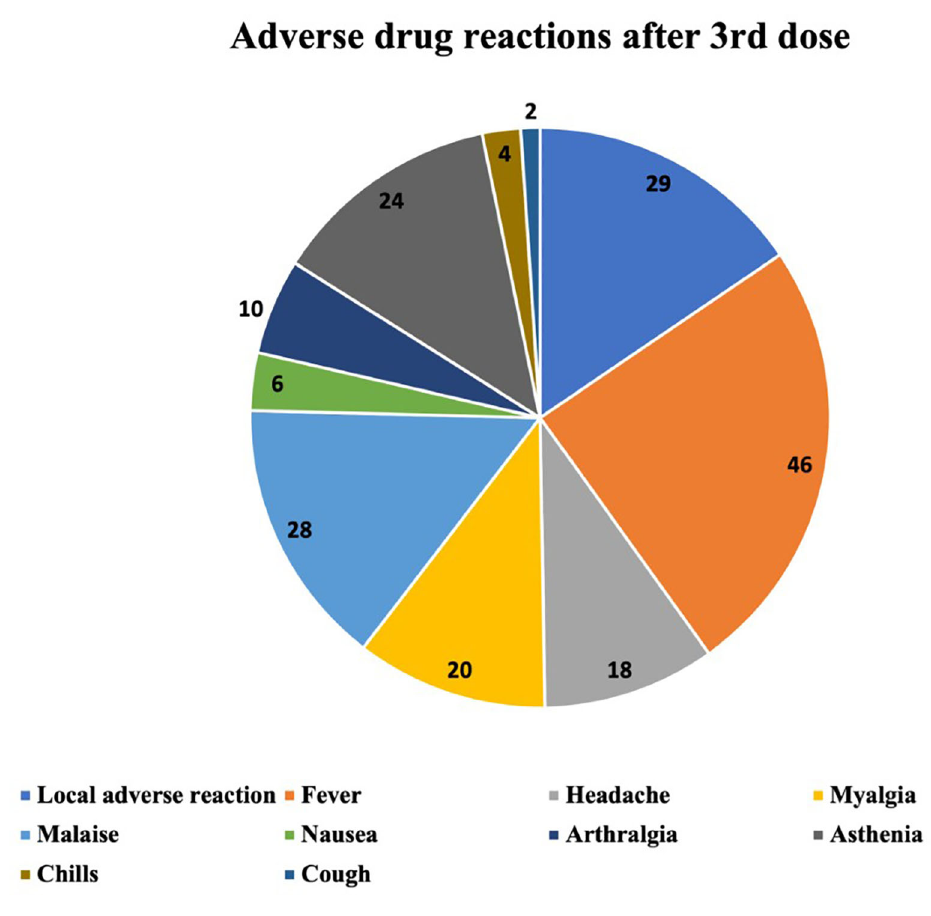
Figure 4. Number and type of adverse drug reactions after 3rd dose.